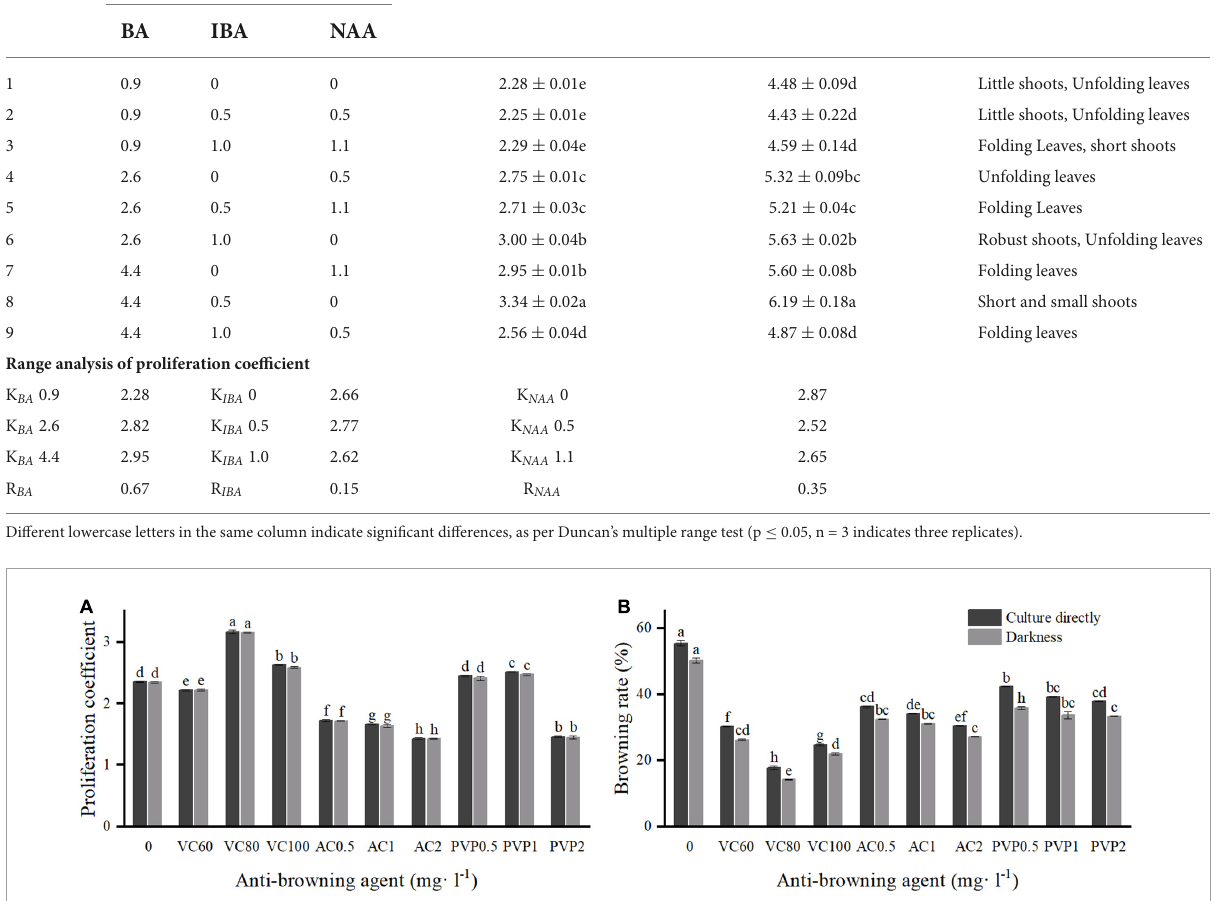
Growth state of plantlets Number of effective coefficient shoots per explants (Mean ± SE; n = 3) ( ≥ 0.5 cm) (Mean ± SE; n = 3)